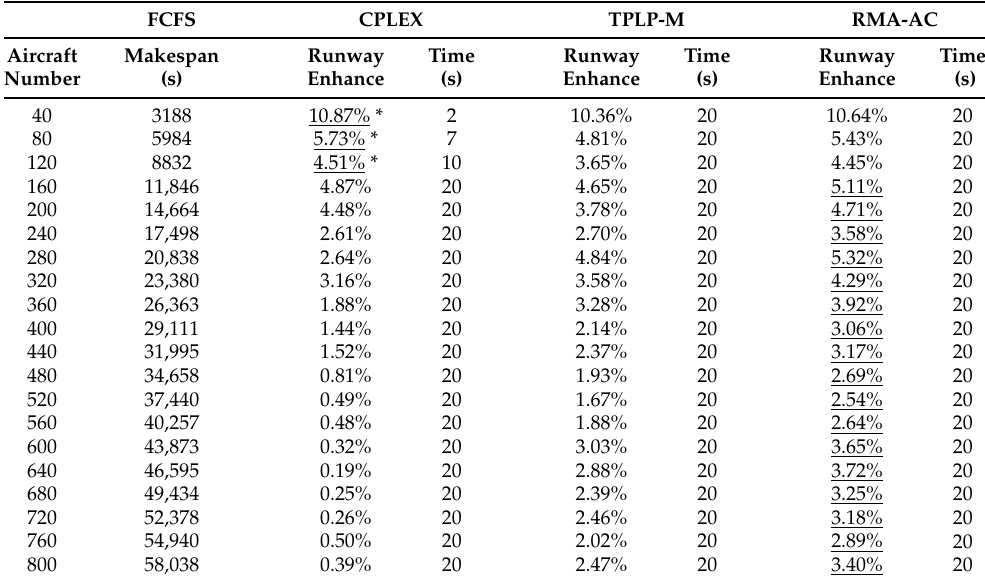
Table 4. A comparison of the solution by the three methods for the random data.